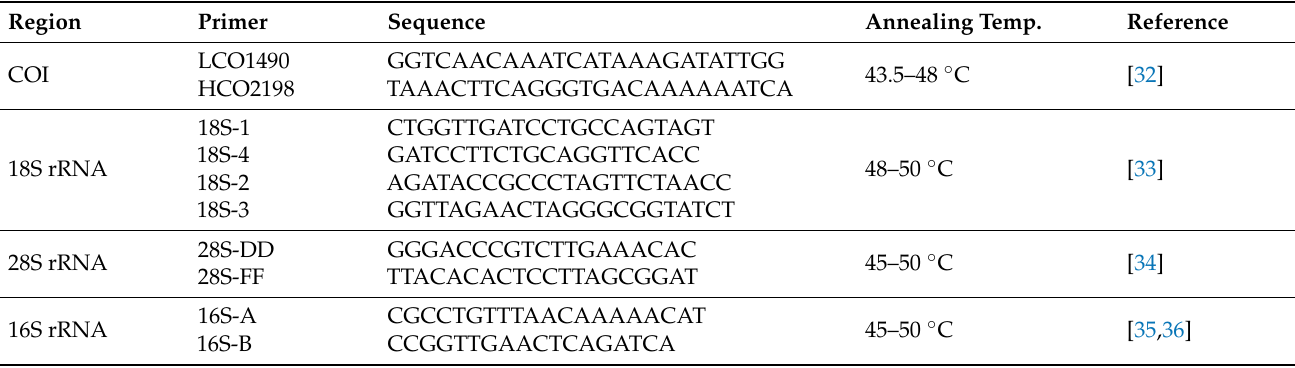
Table 2. Primer sets used in this